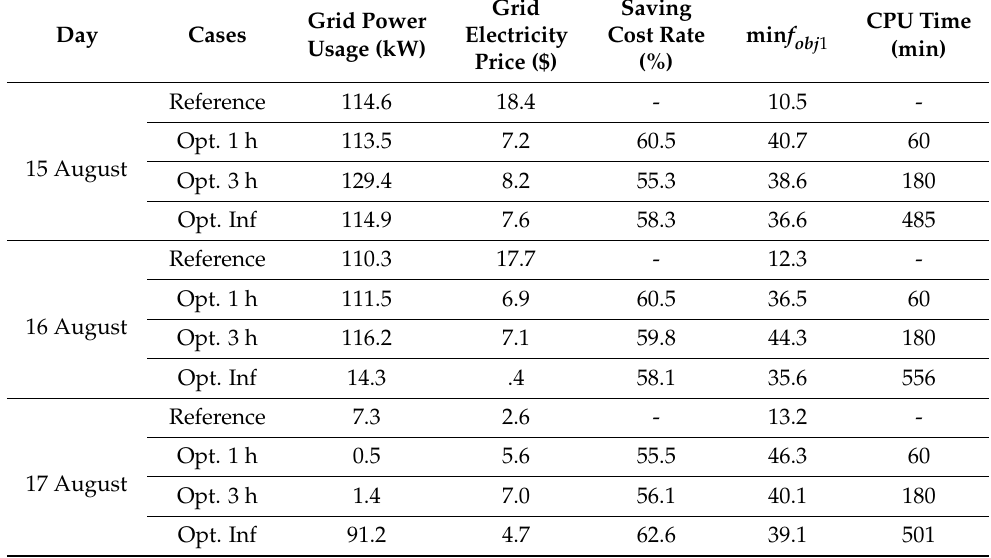
Figure 7. Indoor temperatures depending on test case scenarios. Table 8. MPC results of the target